Question: In one sentence, what is this figure communicating?
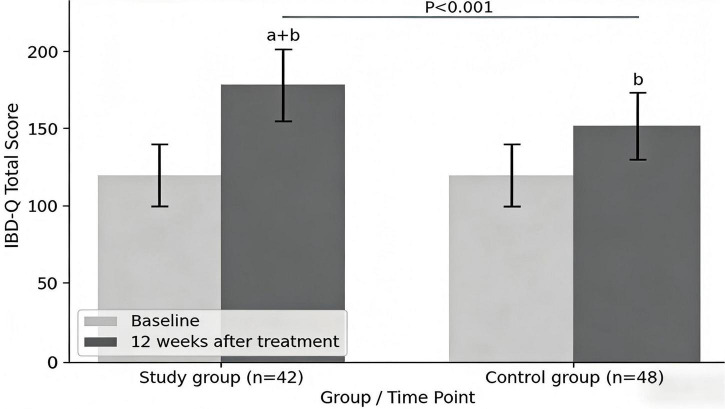
Answer: Comparison of IBD-Q total scores between the two groups at baseline and 12 weeks after treatment. a P < 0.05 vs. control group; b P < 0.05 vs. baseline (0 weeks).